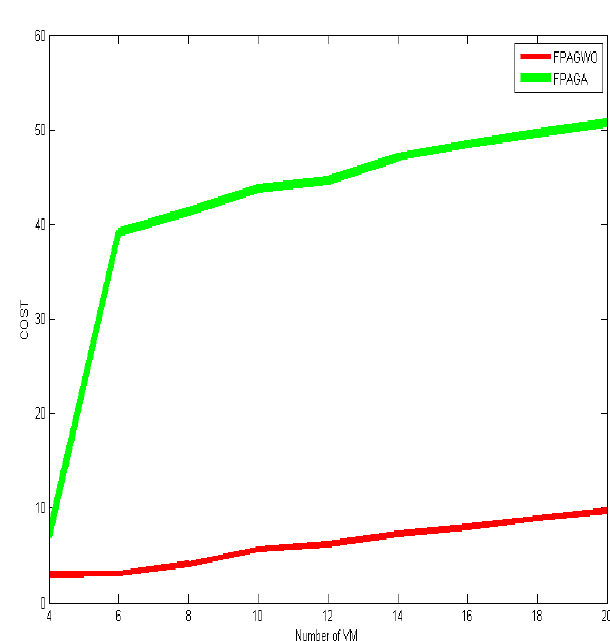
Figure 8. Cost of Sight workflow for FPA_GWO and FPA_GA